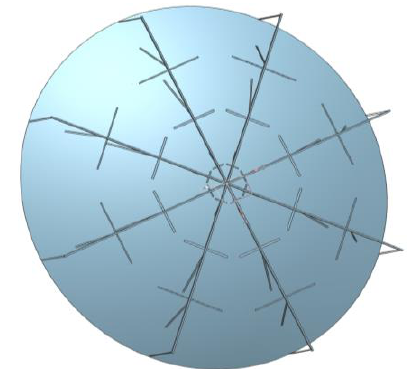
Fig. 1. Geometric model of the transformable antenna